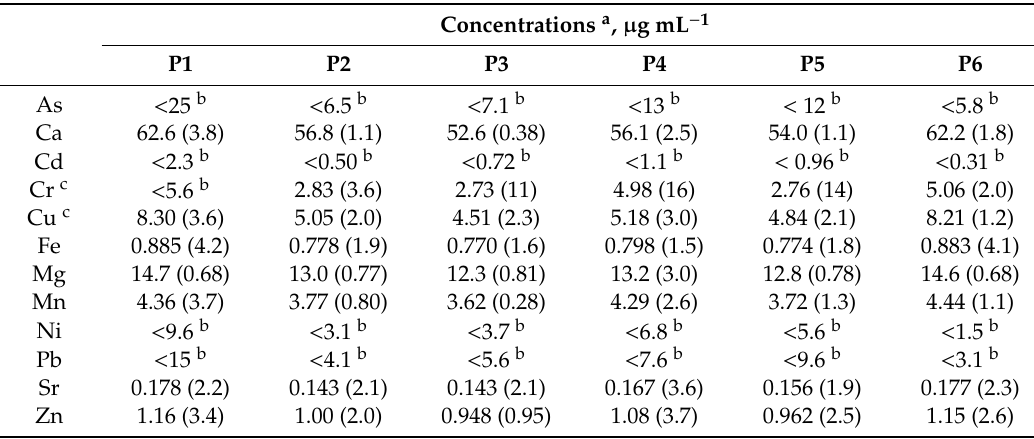
Table 2. Concentrations of elements determined by ICP OES in the selected birch sap (BS9) prepared before measurements using di ff erent sample preparation procedures.